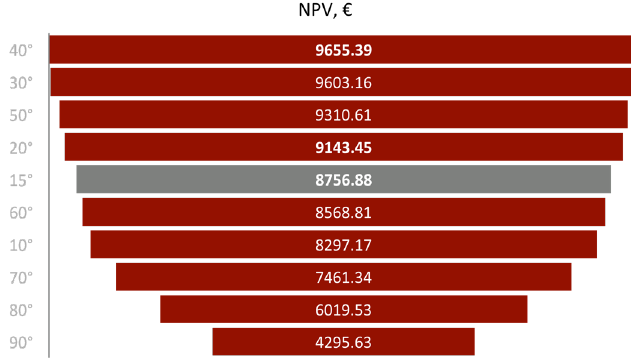
Fig. 5. NPV in € at different roof tilt. The value obtained when the angle is equal to 15° (case study) are pointed out in grey. NPV is equal to € 9655.39 with an inclination angle of 40° (maximum value), while it becomes equal to € 4295.63 with an inclination angle of 90° (minimum value). In both cases,